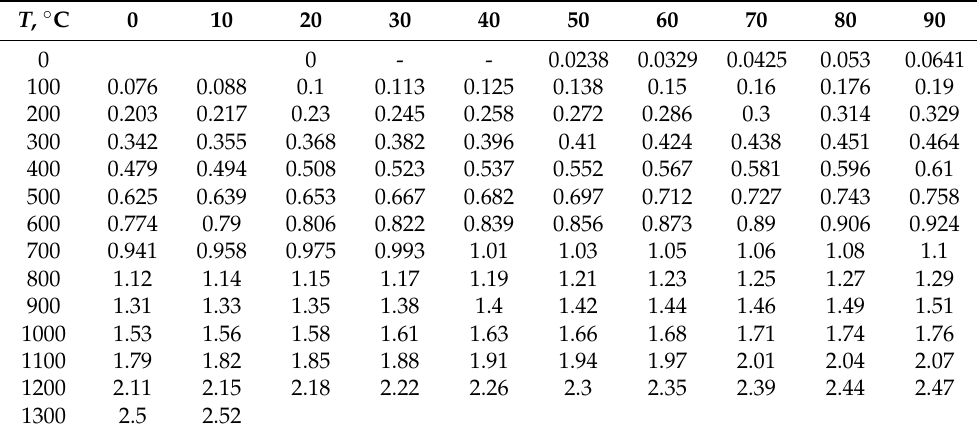
Table A1. Thermal expansion of CMSX-4 as a function of temperature, ε T = f ( T ) , in %. Rows in –100 ◦ C intervals, and columns in –10 ◦ C